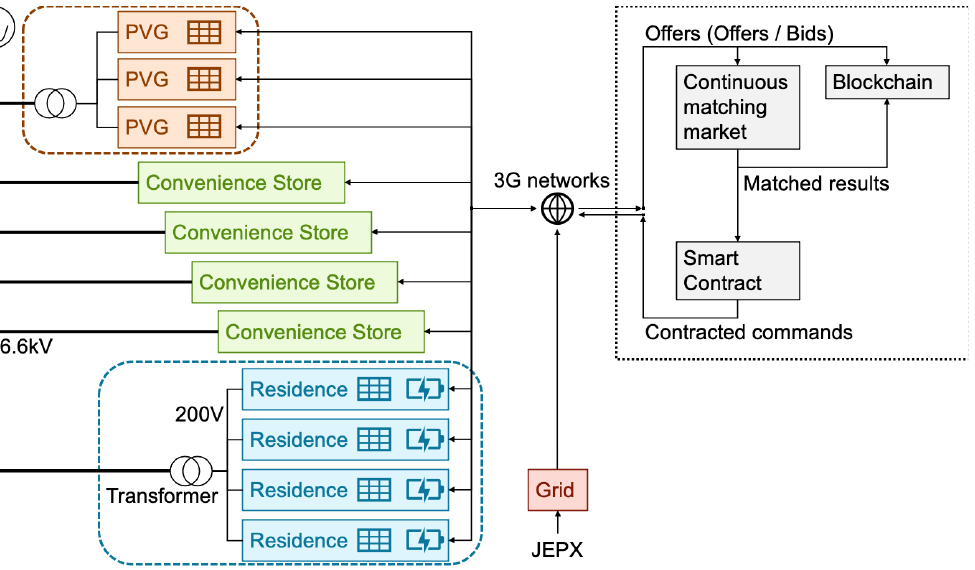
Figure 1. System for the Urawa-Misono demonstration project (reproduced with permission from Kontani et al. [18], under CC-BY license from MDPI (Basel, Switzerland), 2021).